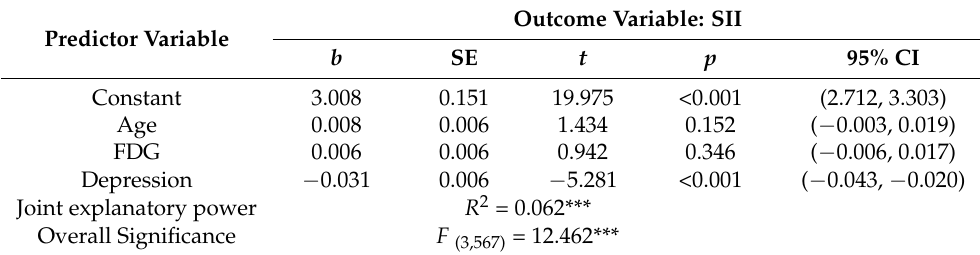
Table 2. Results of regression analysis of depression and impulse inhibition. Predictor